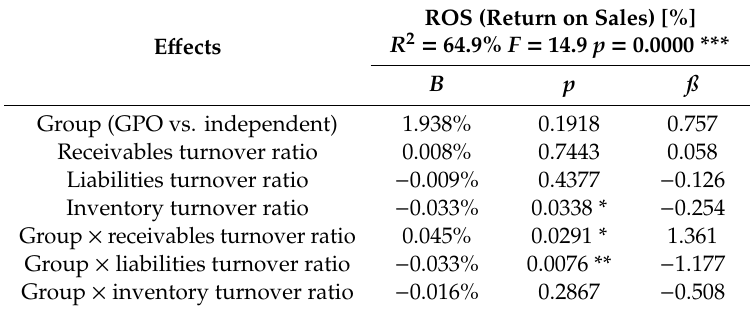
Table 2. Results for regression model with ROS as a dependent